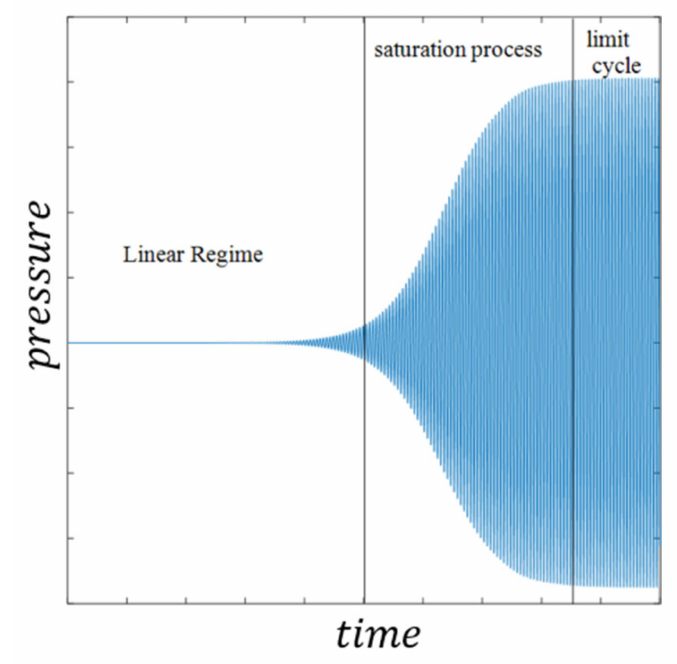
Figure 4. Typical dynamics of pressure oscillations for a thermoacoustic linear regime (exponential rise), saturation process and limit